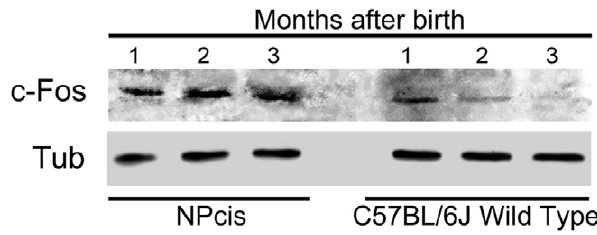
Figure 4. c-Fos expression in NPcis and C57BL/6J WT mice brain according to age and to the proliferative status of the tissue. c-Fos content was determined by WB in brain homogenate from NPcis and WT mice at the ages indicated (upper panel). Tubulin was used as a loading control (lower panel). Results shown are from one representative experiment out of two performed.